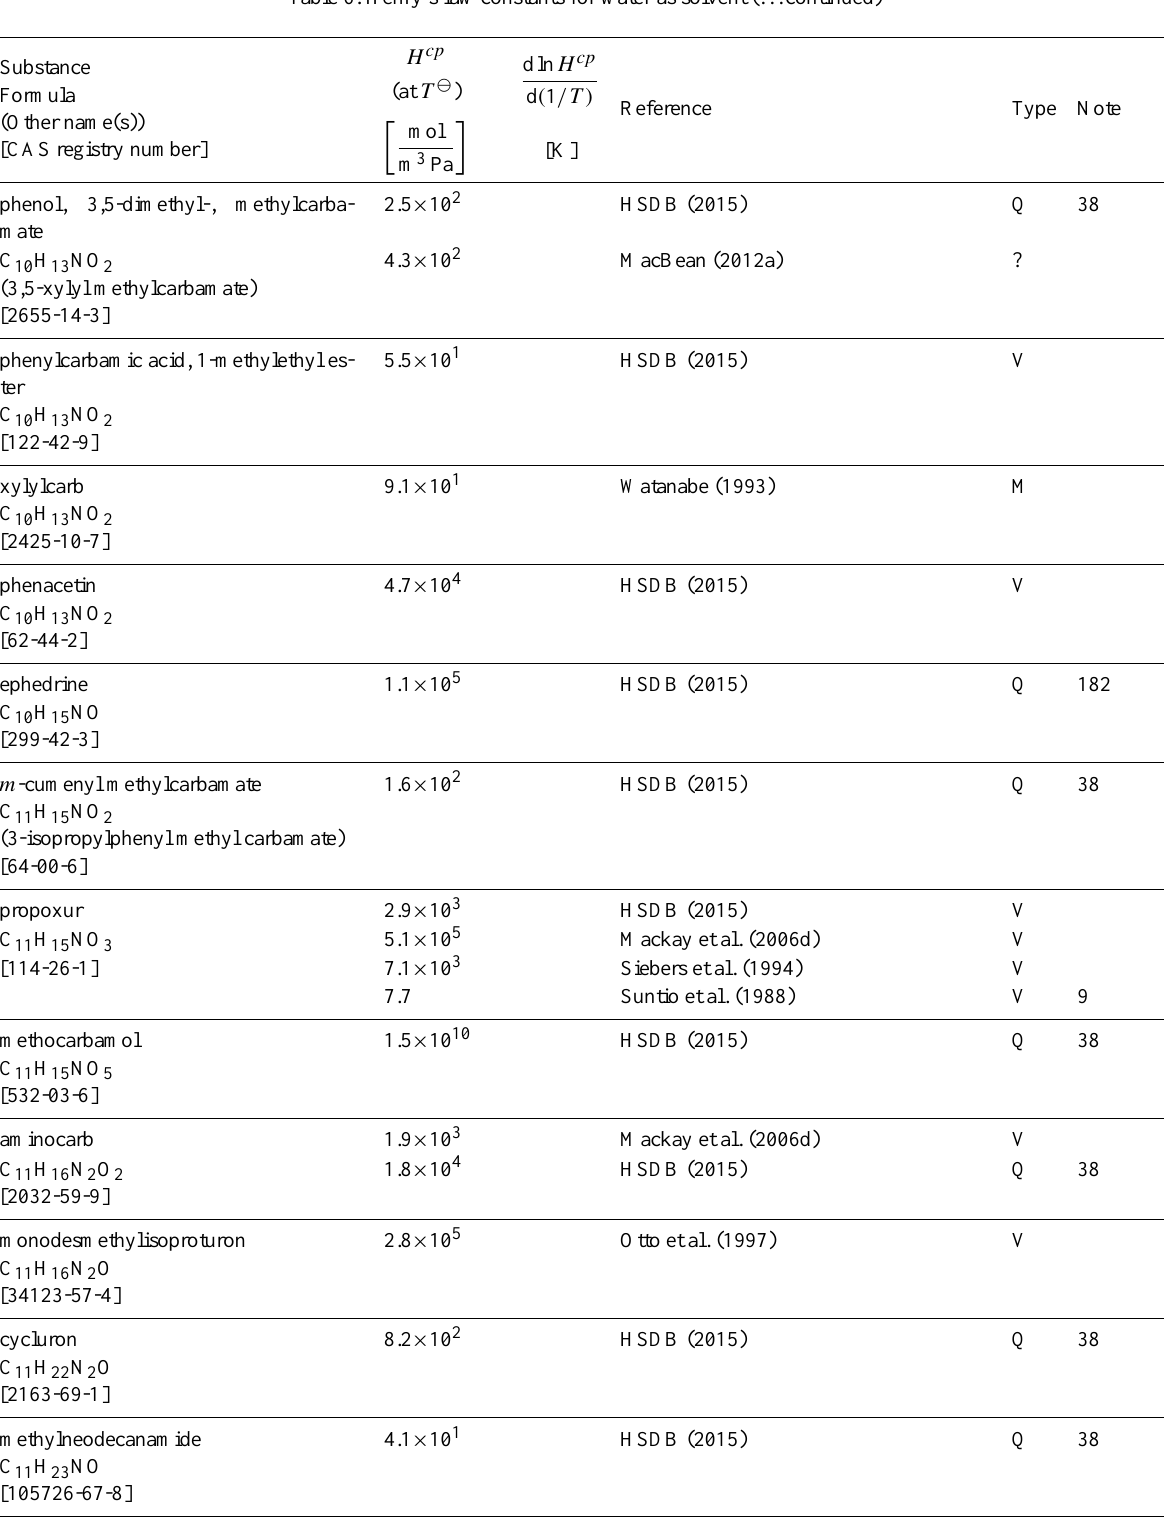
Table 6: Henry’s law constants for water as solvent